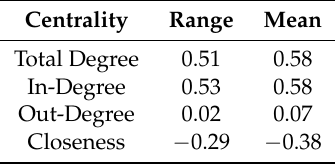
Table 9. Correlations between centrality and the range and average percentage outbreaks.